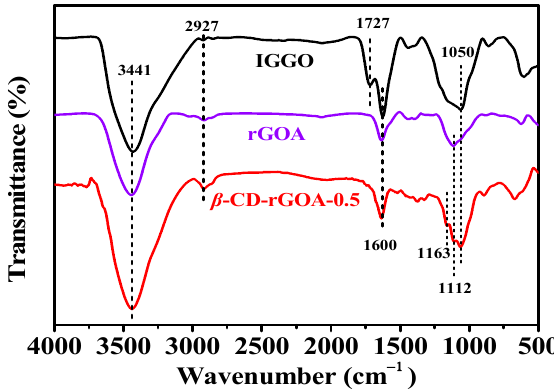
Figure 6. FTIR spectra of IGGO, rGOA, and β -CD-rGOA-0.5. In accordance with the experimental results, a possible working mechanism was elucidated (Figure 7). In a 180 ◦ C hydrothermal enviroment, carbonyl groups can be efficiently reduced to hydroxyl groups, and the ring-opening reaction of an epoxy group occured to form a hydroxyl group. After the modification of β -CD on the rGOA surface, the π – π stacking between the graphene sheets can be weakened; with the hydroxyl group generated, the H-bonds would be increased. When hydroxyl segments at the edge and plane of rGOA interact through hydrogen bonding, a porous 3D structure is possibly facilitated. In this manner, β -CD-rGOA-0.5 can provide more active sites and channels, whereas the adsorption ability was increased.